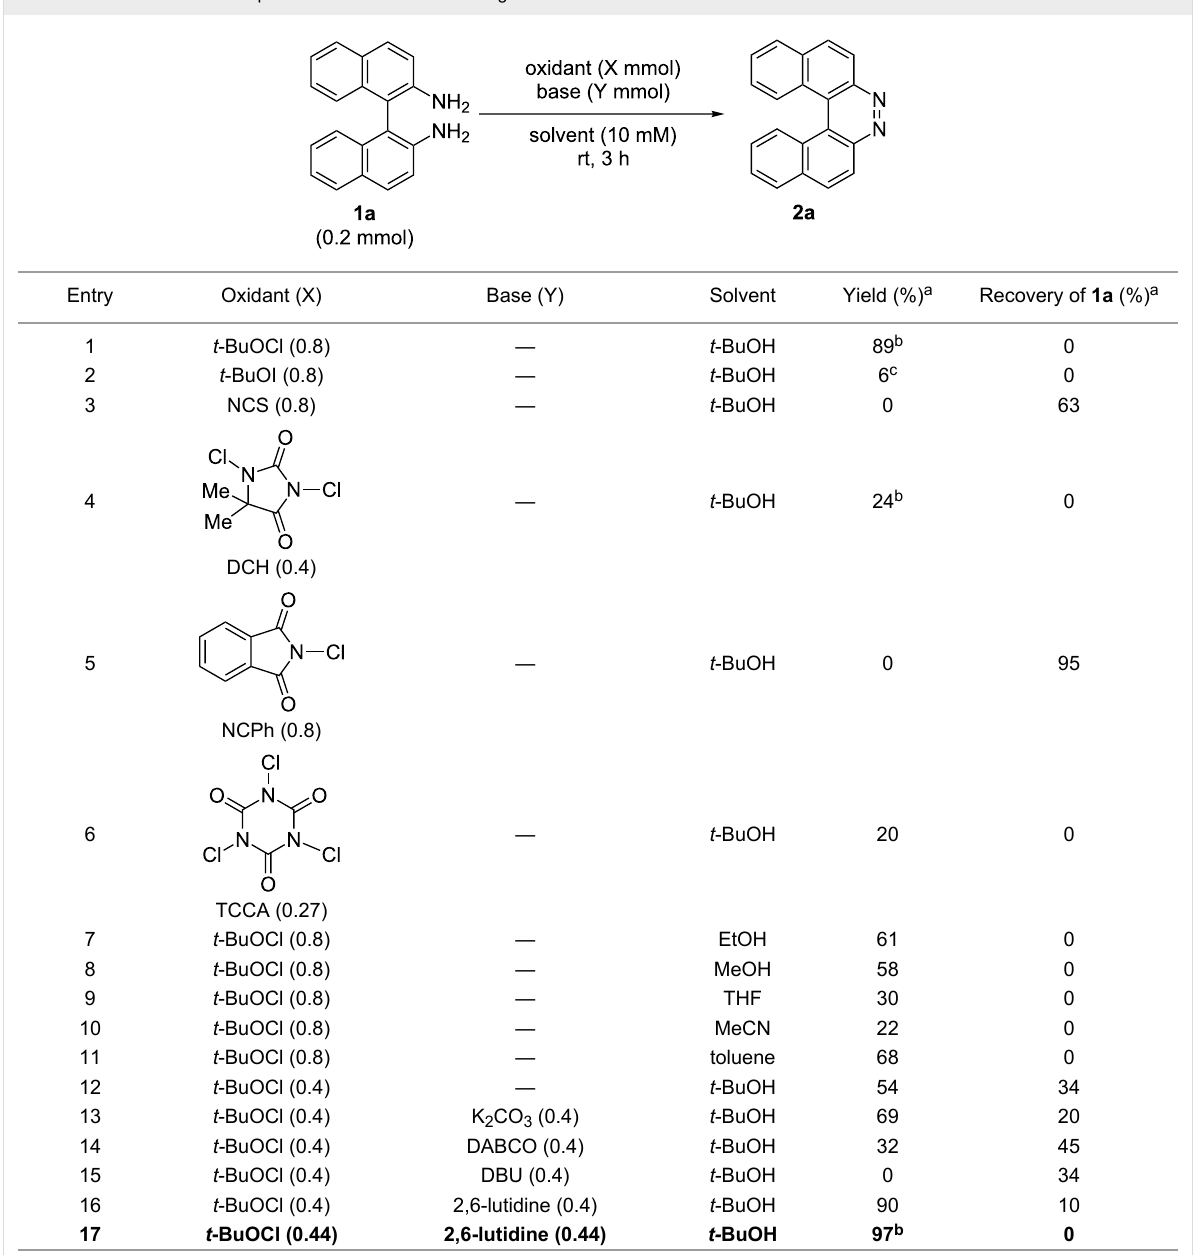
Table 1: The effect of reaction parameters on the oxidative ring-closure of 1a